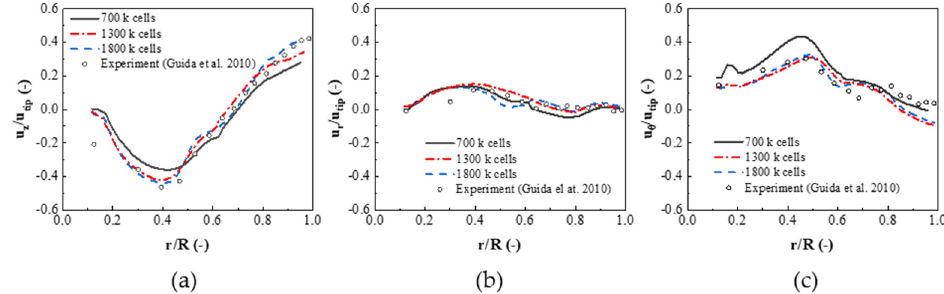
Figure 6. Comparison of radial profiles of liquid velocity with experimental results ( z = 0.2 H ). ( a ) Axial velocity component u z , ( b ) radial velocity component u r , ( c ) tangential velocity component u θ .